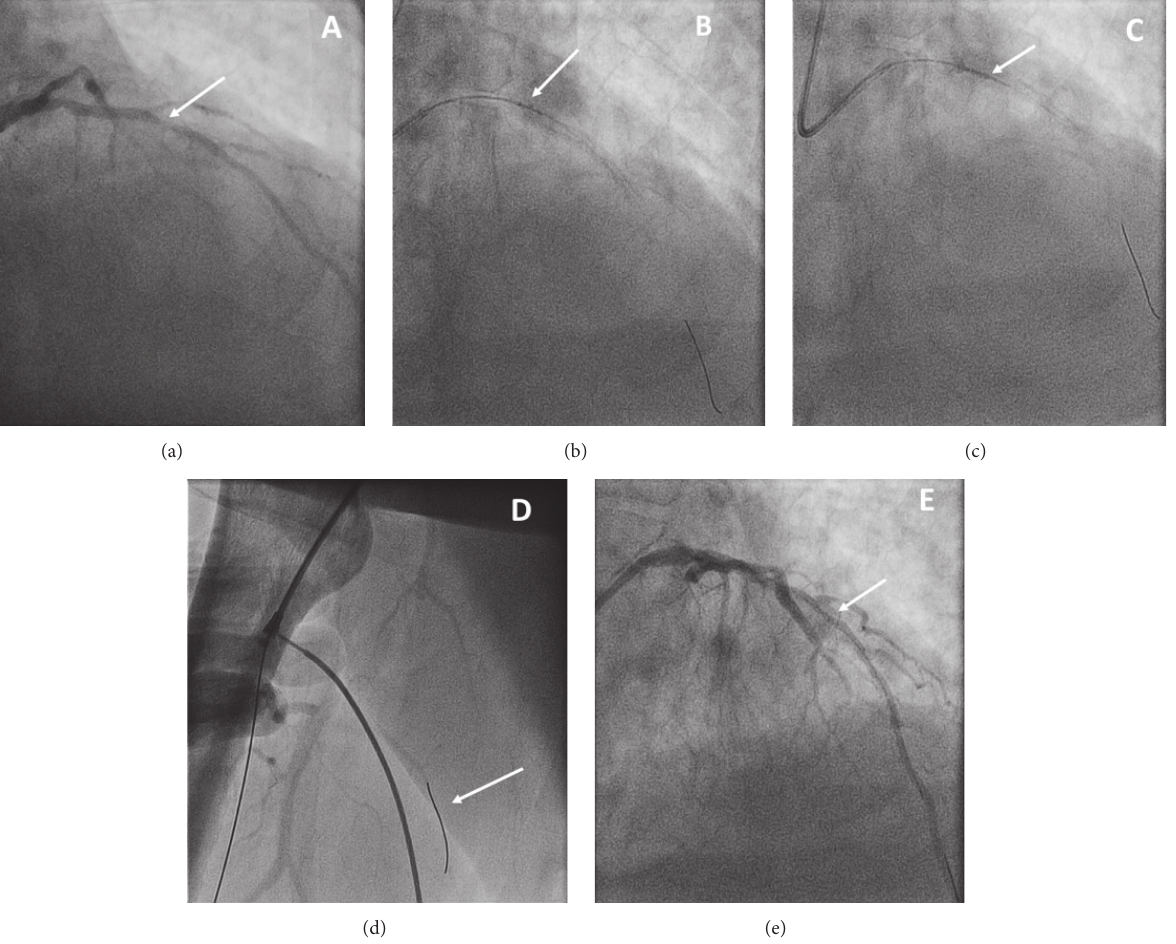
Figure 1: (a) RAO caudal projection, identifying 90% in-stent restenosis of LAD (white arrow). (b) RAO cranial projection showing orbital atherectomy system engaged in stent (white arrow). (c) Radiopaque distortion of device head showing unraveling of driveline coils (white arrow). (d) Viper wire embolized in small distal right profunda femoris artery (white arrow). (e) RAO cranial projection, final result, showing widened luminal area of in-stent restenosis (white